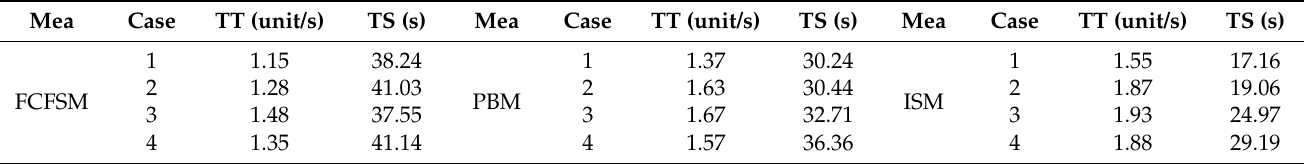
Figure 14. Number of vehicles queued at the intersection (queue lengths) with different combinations of λ 1 and λ 2 . Table 4. Comparision of FCFSM, PBM, and ISM under different